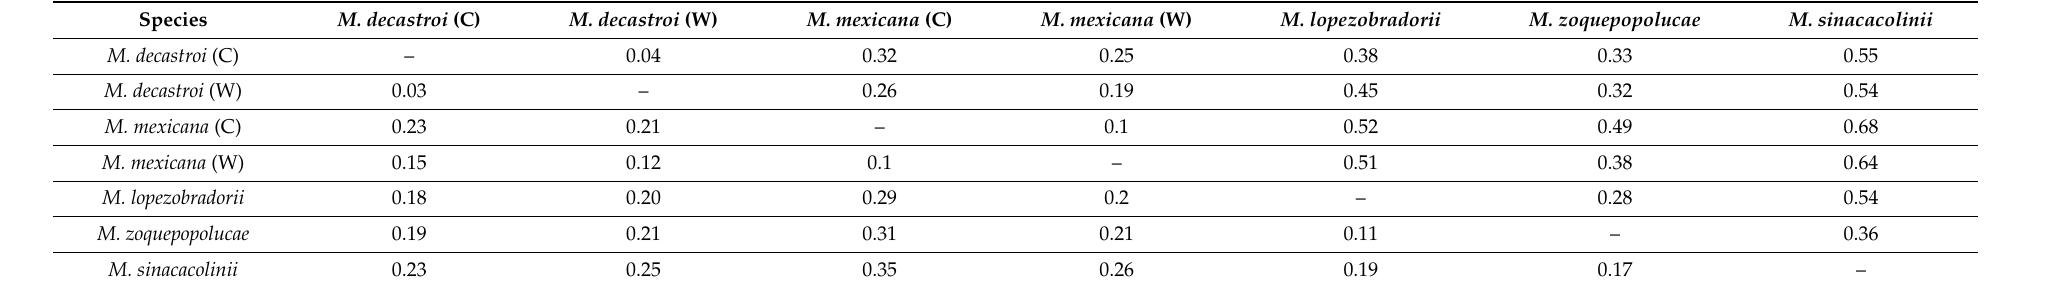
Table 3. Pairwise F ST and D JOST values between the five Magnolia species studied in Puebla and Veracruz, Mexico. Above the diagonal pairwise D JOST values are tabulated. Below the diagonal pairwise F ST values are tabulated. Metadata can be found in Table 5; (C) marks cultivated sampling localities as opposed to wild (W) sampling localities.